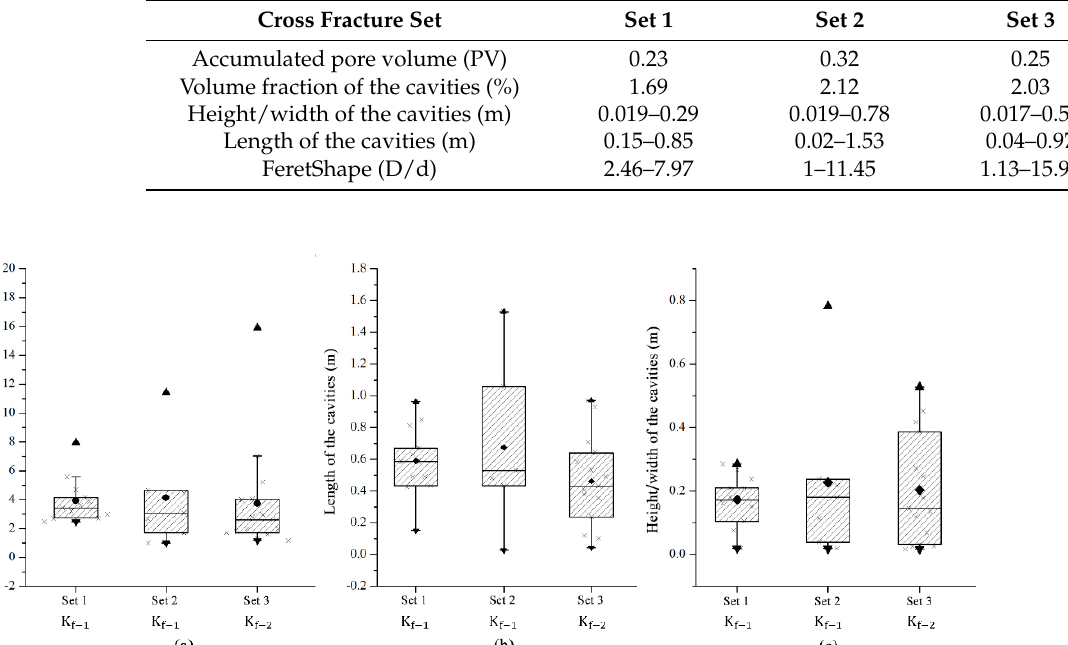
Table 4. Statistics parameters for different cross fracture networks.